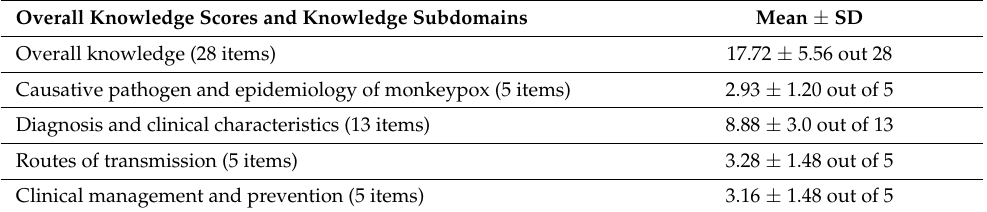
Table 2. The total scores of the overall knowledge and subdomains of knowledge.